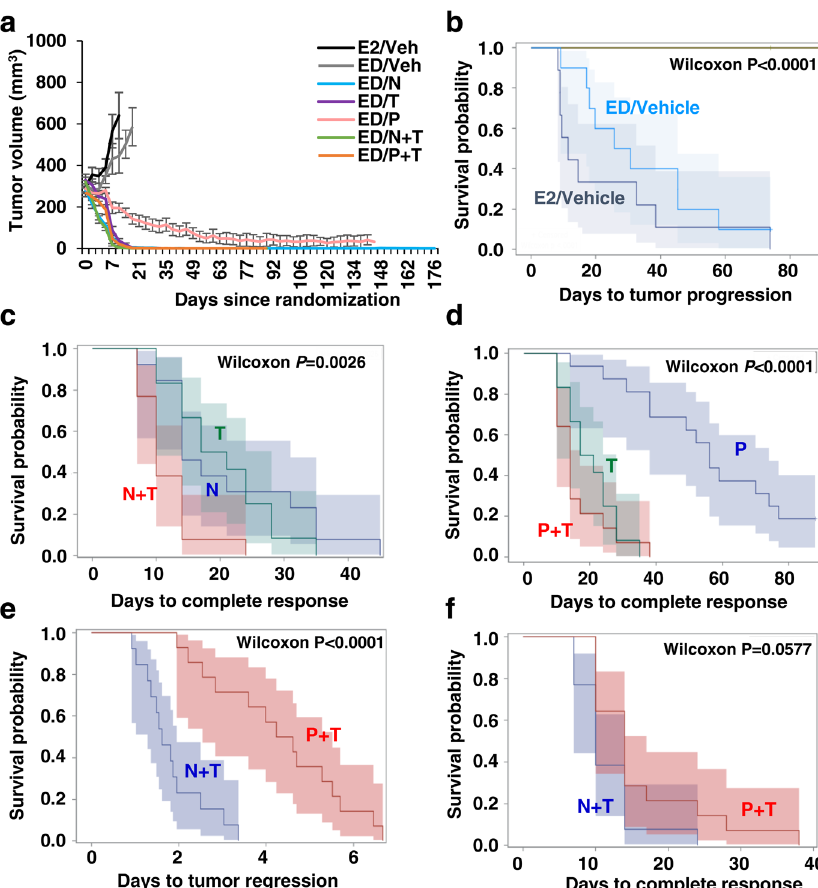
Fig. 1 Neratinib (N) containing anti-HER2 regimen shows superior anti-tumor ef fi cacy than trastuzumab (T) and pertuzumab (P) in BT474 cell-derived xenograft model. a Average growth curves of tumors treated with Vehicle, N, T, P, N + T, or P + T ( n = 9 – 14). Results are presented as mean tumor volume ± SEM. Kaplan – Meier analysis of b time to tumor progression in mice treated with different anti-HER2 therapies, c time to complete response in mice treated with N, T, or N + T, d time to complete response in mice treated with T, P, or T + P, and e time to tumor regression and f time to complete response in mice treated with N + T or P + T. Shaded areas represent point-wise 95% con fi dence regions, calculated using the loglog transform. P values are indicated on plots, Wilcoxon test; Veh Vehicle, ED estrogen deprivation. Table 1. Primary study endpoints following different anti-HER2 therapies in BT474 cell line-derived and BCM-3963 patient-derived xenograft models.